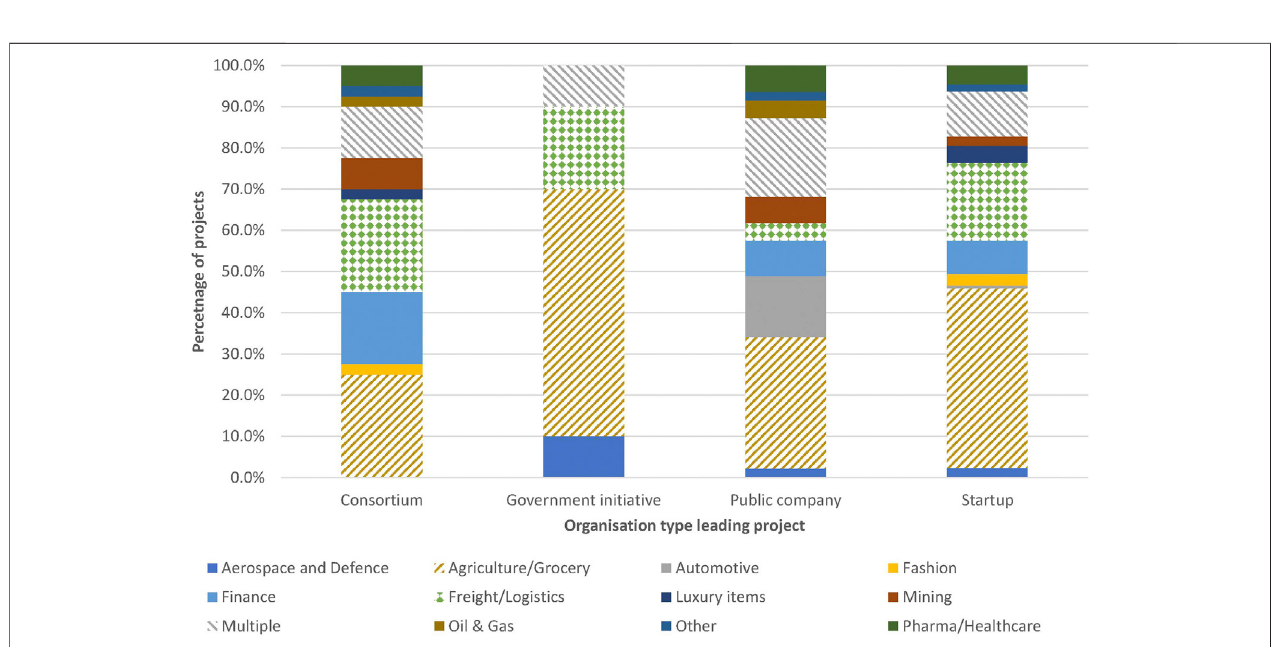
FIGURE 8 | The percentage of projects operating in different sectors based on the type of organization leading the project.